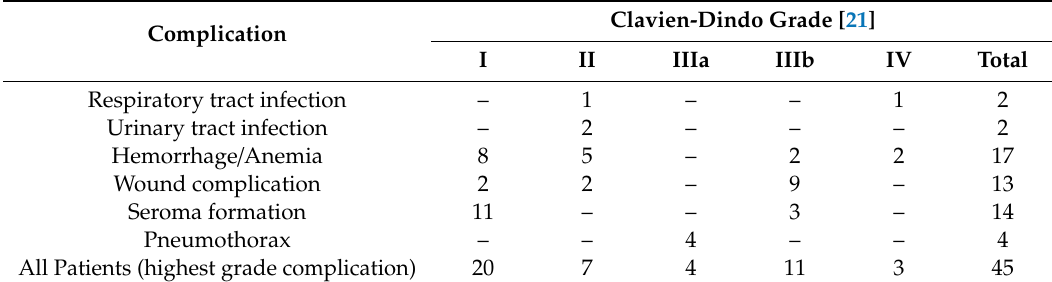
Table 1. Postoperative complications by Clavien-Dindo grade.